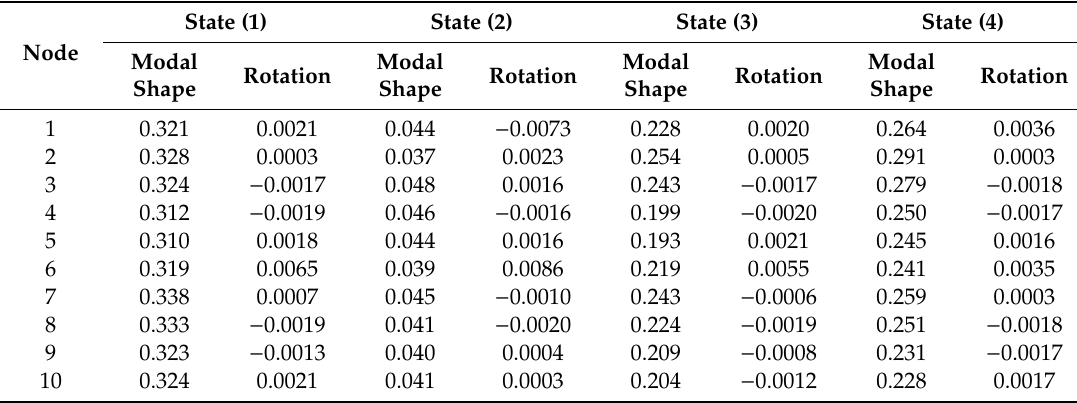
Table 5. The first-order modal shape based on high-speed